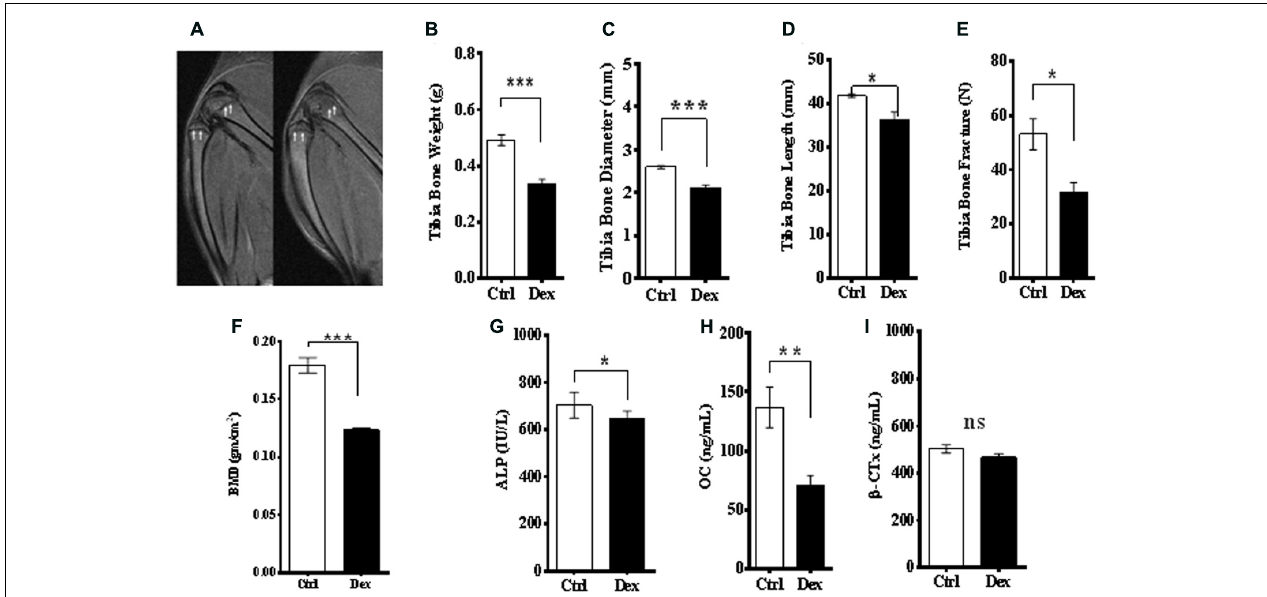
FIGURE 2 | Effects of Dex treatment on bone tissues. A representative MRI of knee and lateral femur and tibia in Ctrl (left), and Dex (right) shows a bone deformity in Dex treated animals compared to Ctrl (A) . There was a significant reduction in dry bone weight of tibia (B) , tibia diameter (C) , tibia length (D) and (femur) bone mineral density measured by µ -CT (E) , where the p -values were < 0.0005, < 0.002, < 0.05, and < 0.0001, respectively. Tibia bone fracture force was significantly reduced in Dex group ( p < 0.02) compared to Ctrl (F) . Serum levels of alkaline phosphatase (ALP) (G) and osteocalcin (OC) (H) are significantly reduced in Dex treated animals ( p < 0.02 and < 0.002 respectively) while β -crosslaps ( β -CTx) levels were not ( p > 0.2) (I)